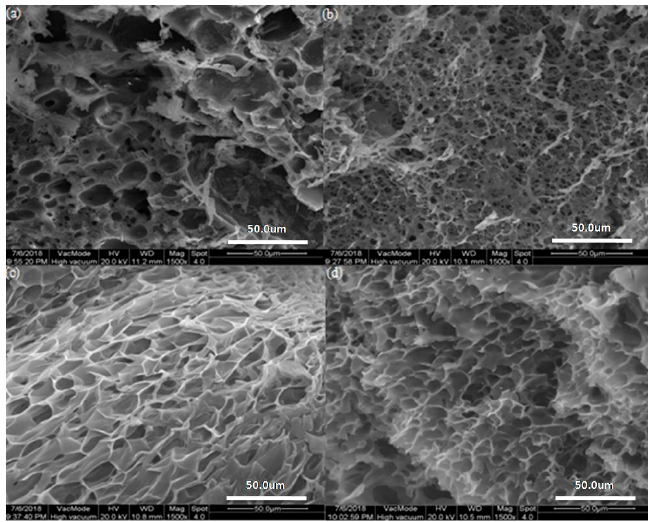
Figure 8. Morphology of gel1 at 25 ◦ C ( a ) and 40 ◦ C ( b ), and the morphology of gel2 at 25 ◦ C ( c ) and 40 ◦ C ( d ).